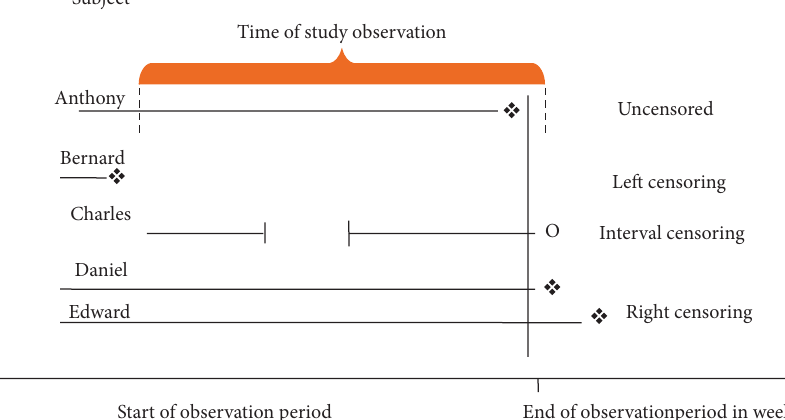
Figure 2: A study on five males illustrative of the three types of